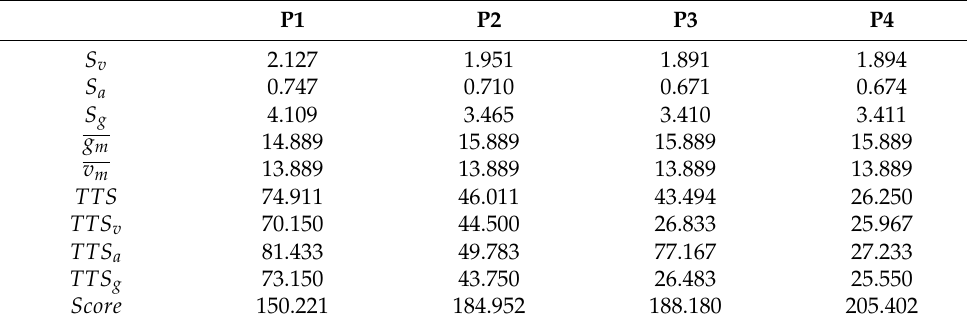
Table 8. CACC test results and evaluation